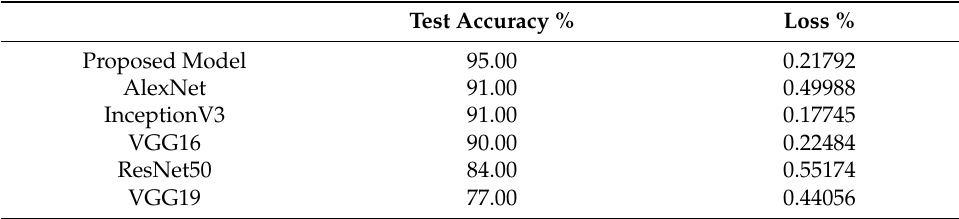
Table 5. Model evaluation using the same training and test